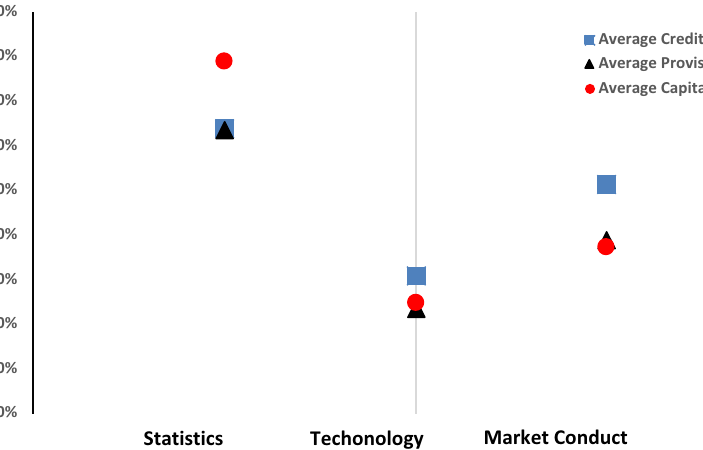
Fig. 3 Comparison between different model